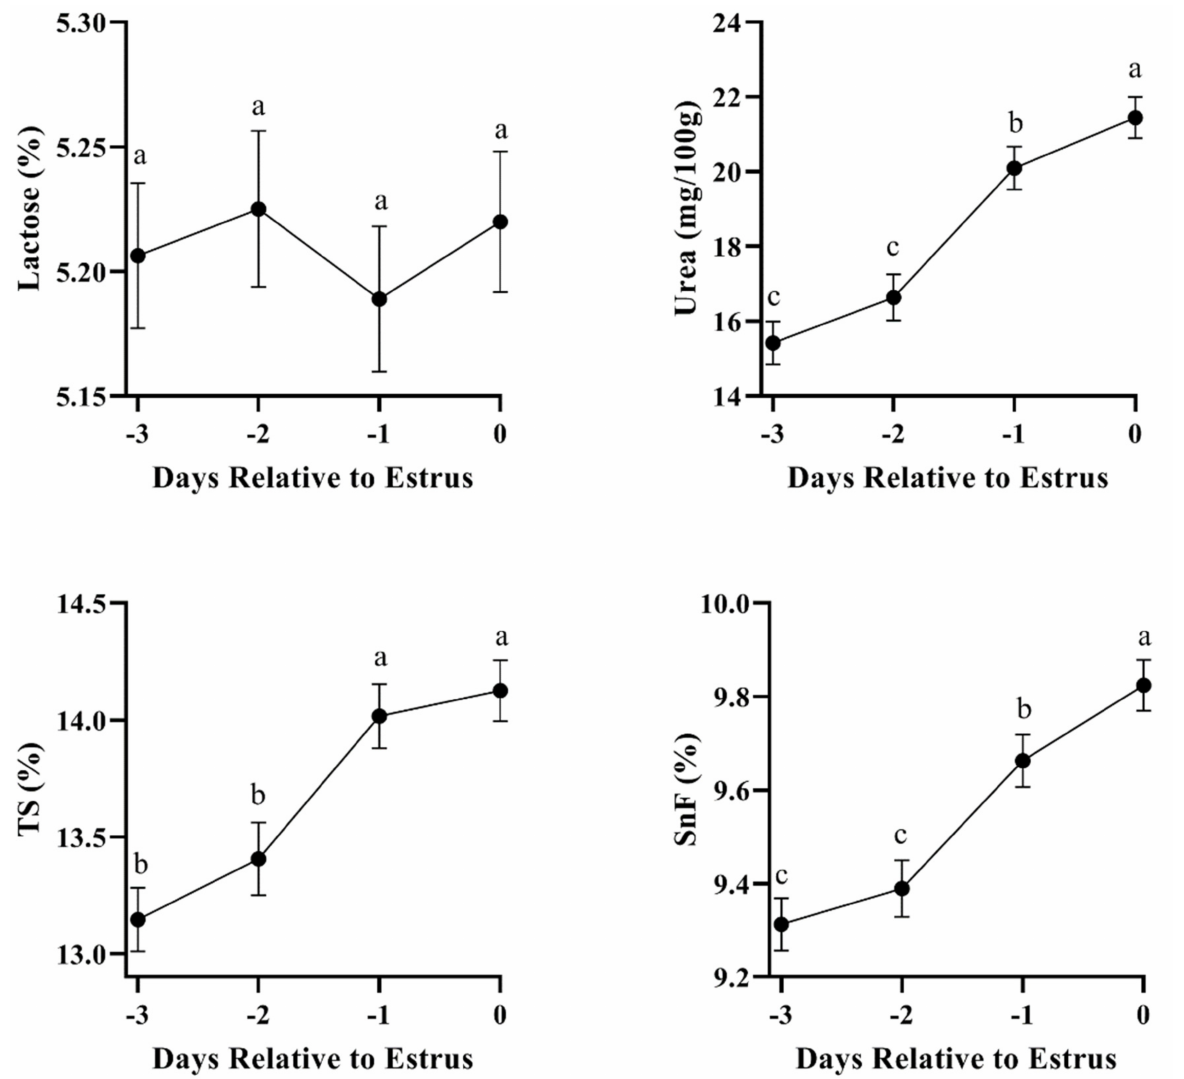
Figure 2. Changes in fat, protein, lactose, urea, total solid (TS), and solid not fat (SnF) from day -3 to day 0. Results are given as the LSQ means ± SE. a,b,c Means with different superscripts differ significantly at p <